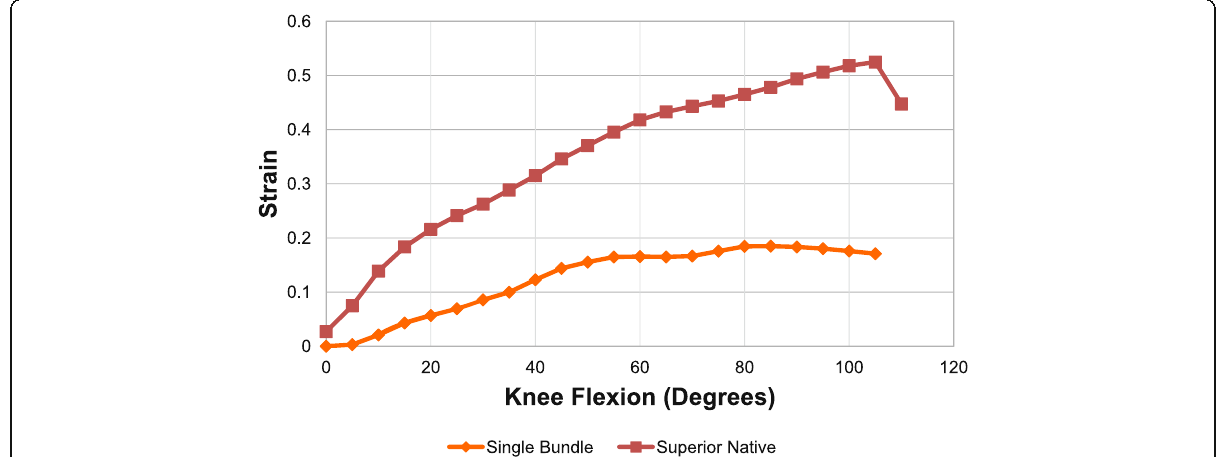
Fig. 7 Strain pattern of intact and single-bundle reconstructed MPFL as knee flexed from 0 to 105 degrees. Red – superior intact, Orange – single